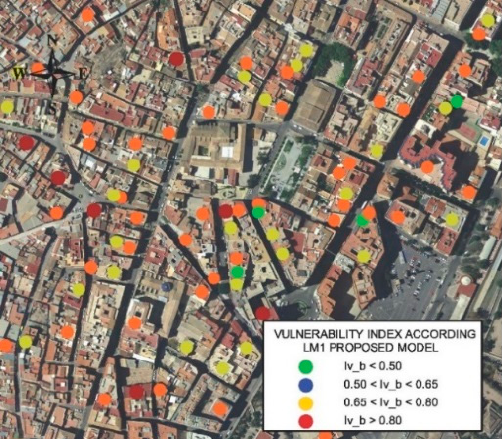
Figure 7. Detail of the urban plot in the southwestern part of the city of Lorca, including the vulnerability indexes Iv b of analyzed RC buildings, according to the proposed model.